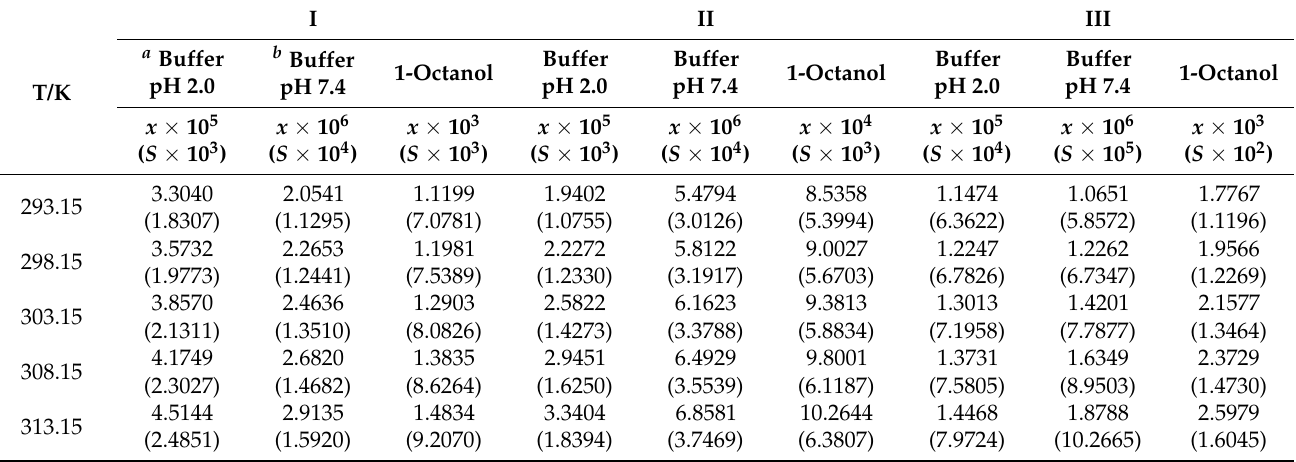
Table 2. Solubility ( S , mol · L − 1 and x , mol. frac.) of compounds studied (amorphous state) in buffer